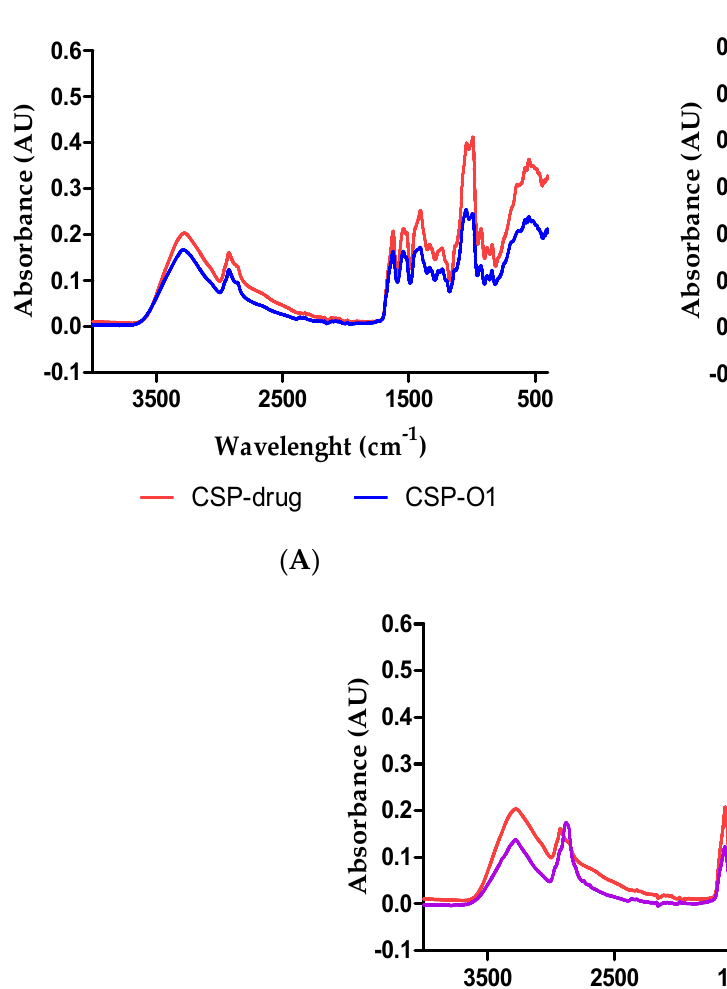
6 of 25 Figure 2. Flow and viscosity curves of samples: ( A ) CSP-O1 at 4 °C; ( B ) CSP-O1 at 25 °C; ( C ) CSP- O1 at 37 °C; ( D ) CSP-O2 at 4 °C; ( E ) CSP-O2 at 25 °C; ( F ) CSP-O2 at 37 °C; ( G ) CSP-O3 at 4 °C; ( H ) CSP-O3 at 25 °C; ( I ) CSP-O3 at 37 °C; and ( J ) SOL-GEL temperature transition of CSP-O3 hydrogel.